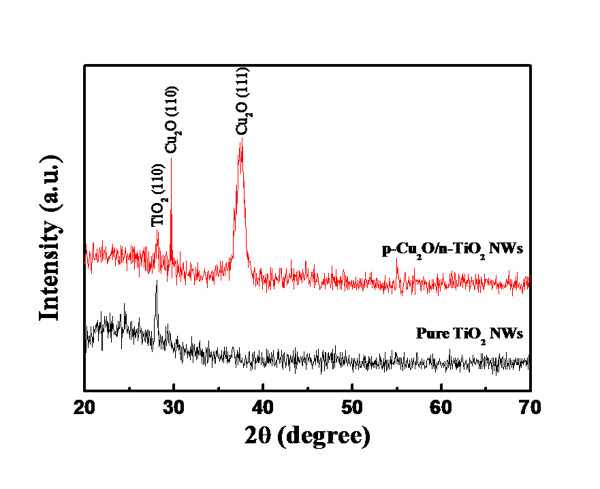
XRD measurements of pure TiO2 nanowires and p-Cu2O/n-TiO2 nanowires obtained by DC sputtering.